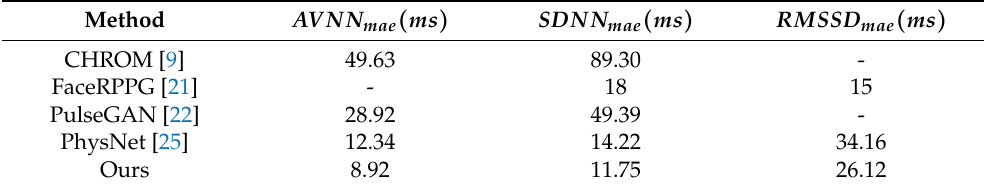
Figure 15. The analysis of the correlation plot ( left ) and the Bland–Altman plot ( right ) of frequency- domain metrics of HRV on the UBFC dataset. ( top ) is LF, ( middle ) is HF, ( bottom ) is LF/HF. Table 4. The result of time-domain metrics on the PURE dataset.